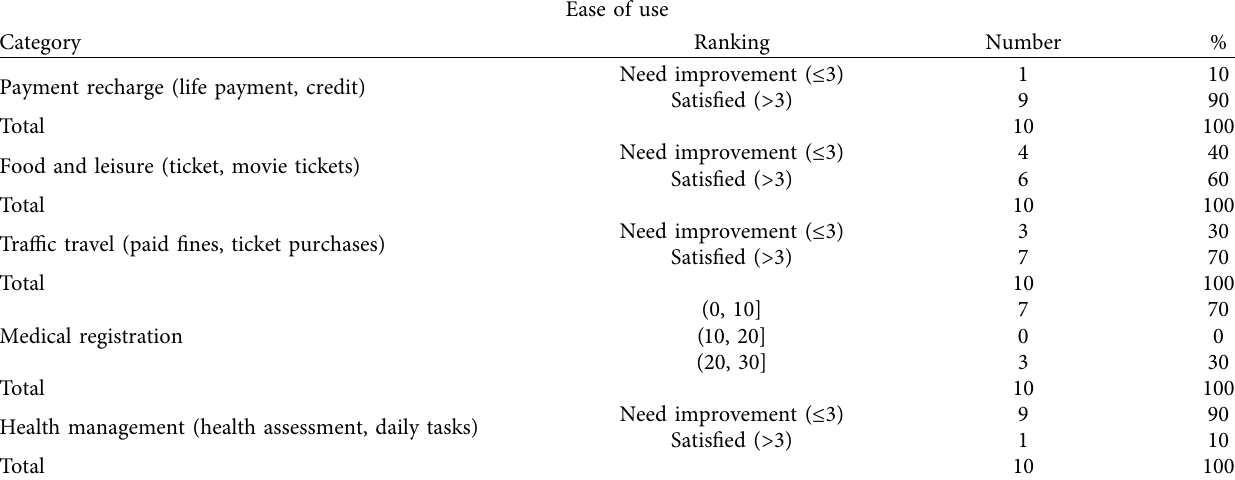
Table 11: Summary of Livelihood payment.